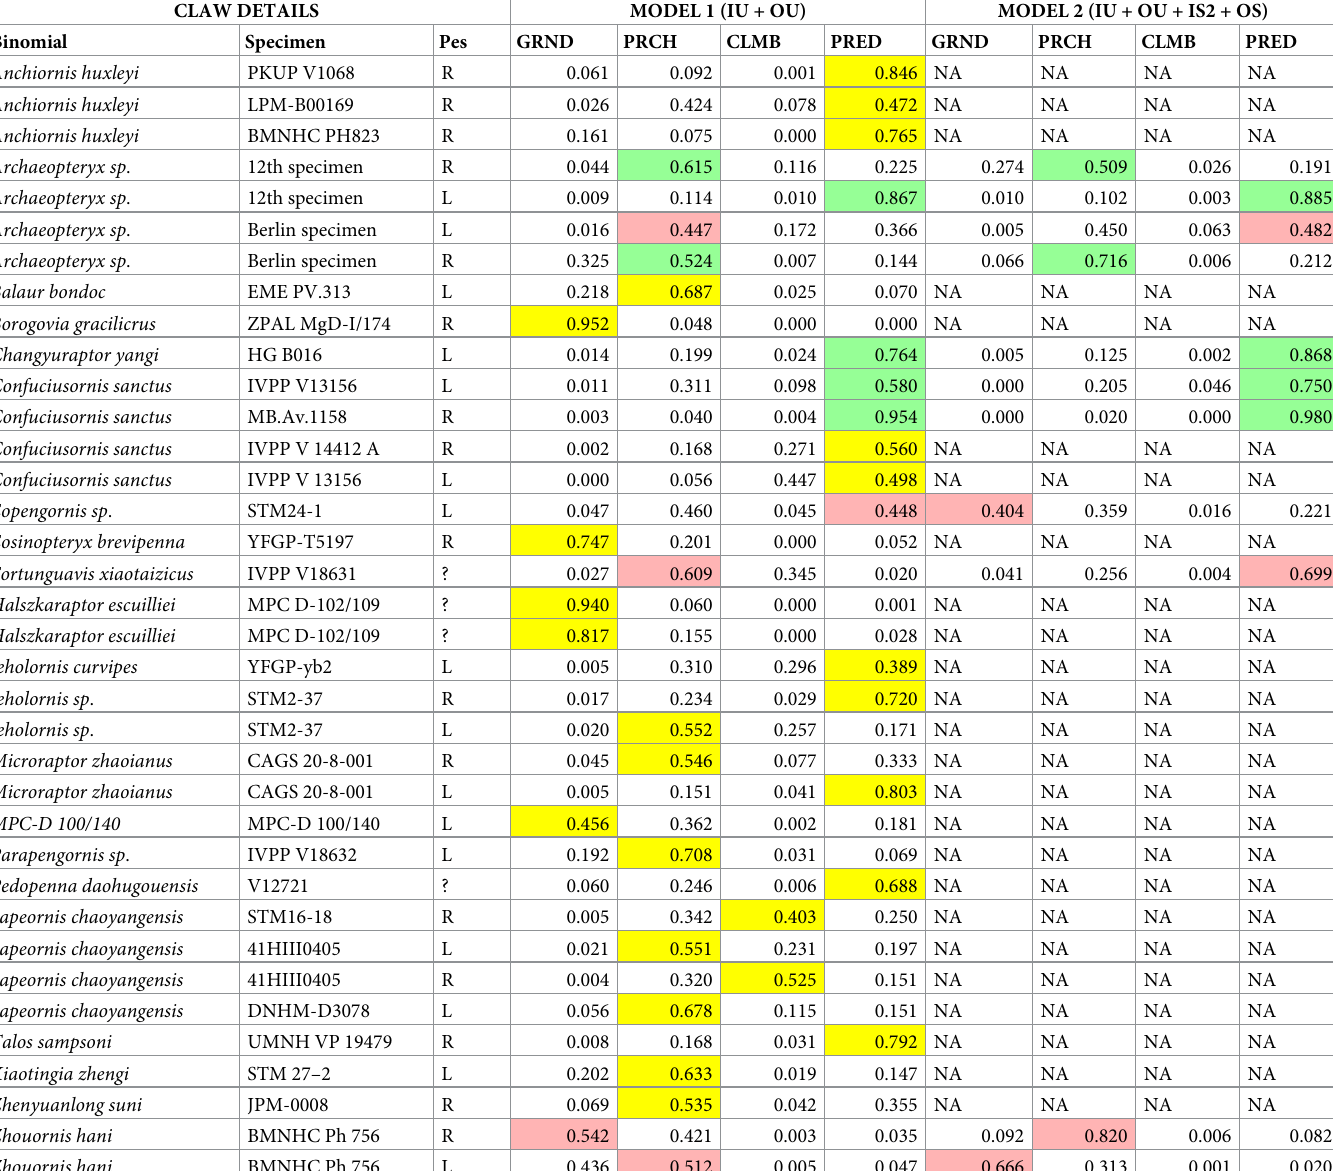
Table 5. Posterior probabilities for fossil claws ecological grouping. Predictions were generated for fossil taxa by two predictive models: Model 1 based on ungual bone curvatures, and for claws in possession of the keratinous sheath, Model 2 based on ungual bone and sheath curvatures. GRND = Ground-dwelling, PRCH = Perching, CLMB = Climbing, PRED = Predatory. Highlighted cells indicate classification for the claw. Yellow = classification by Model 1 alone (no sheath data), green = classification for which Models 1 and 2 are in agreement, red = classification for which Models 1 and 2 are in